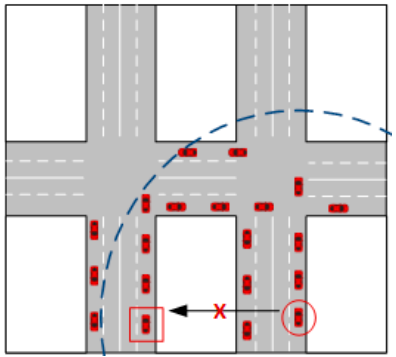
Figure 29. Example of broadcasting. The dashed circle delimits the broadcast area.